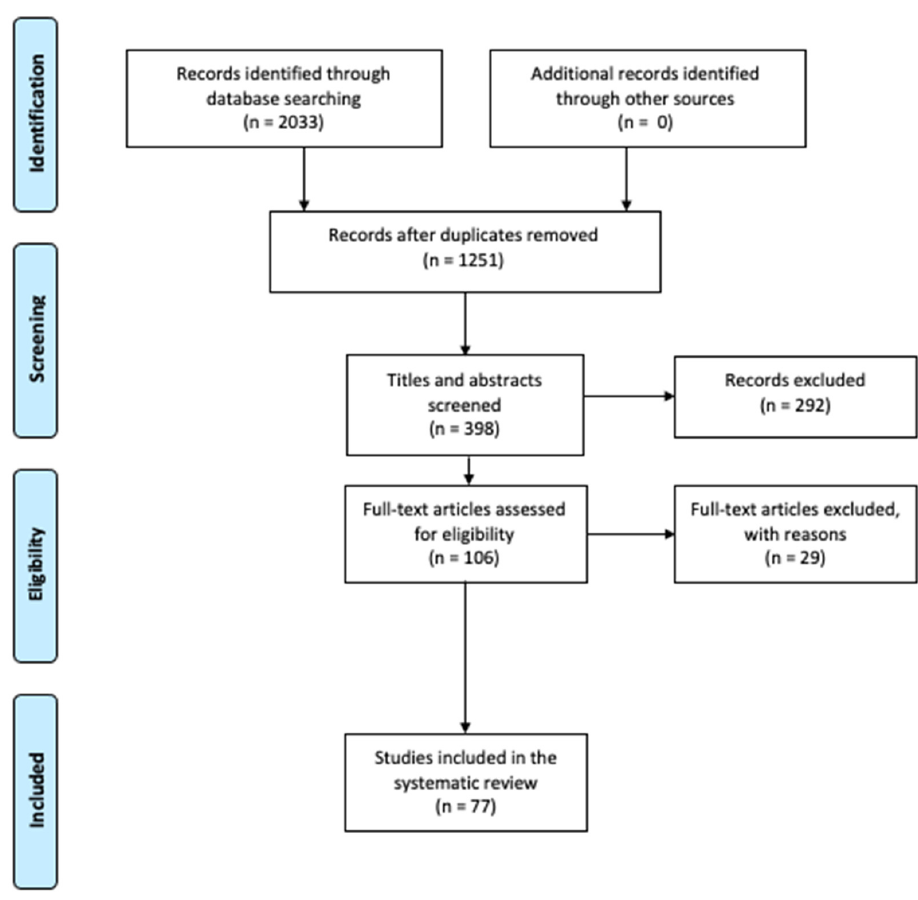
Figure 1. PRISMA flow diagram for study selection.